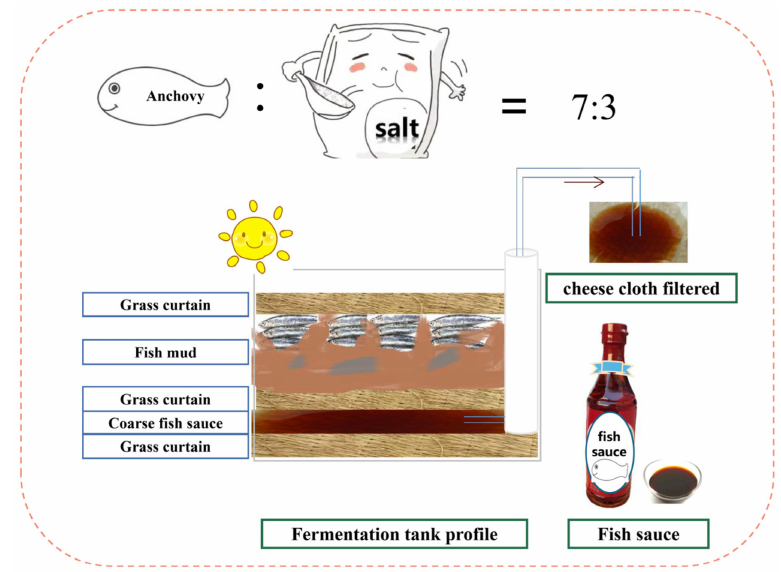
Figure 1. Schematic diagram of fish sauce natural